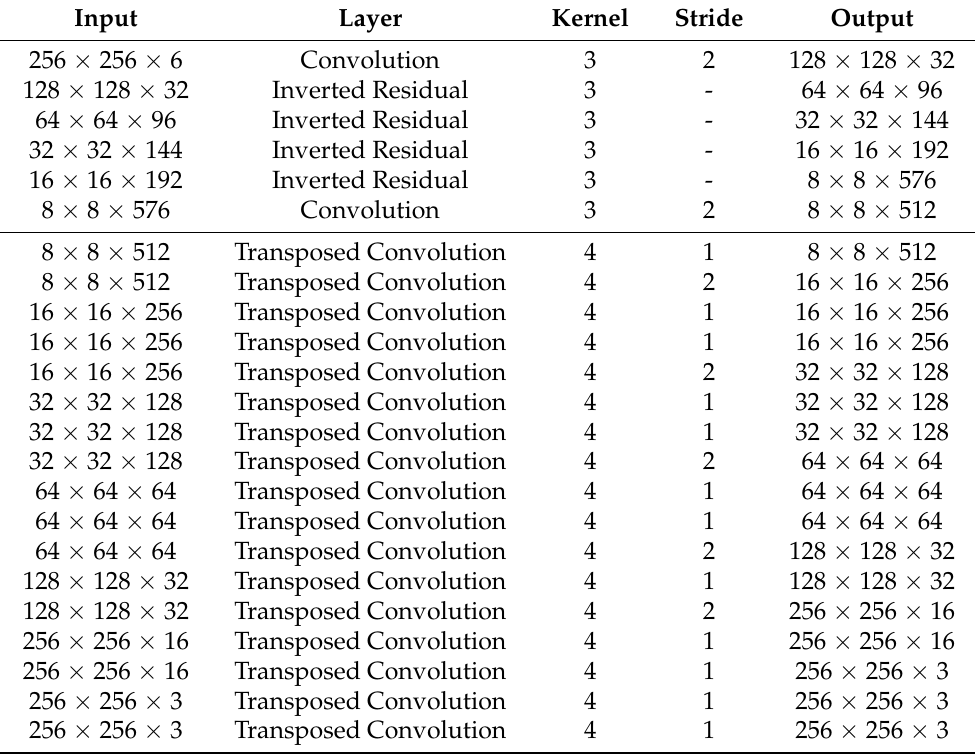
Table 1. A List of all layers in the CNN implementation. The thin horizontal line separates the encoder and decoder network parts, but the actual network is not in any way split